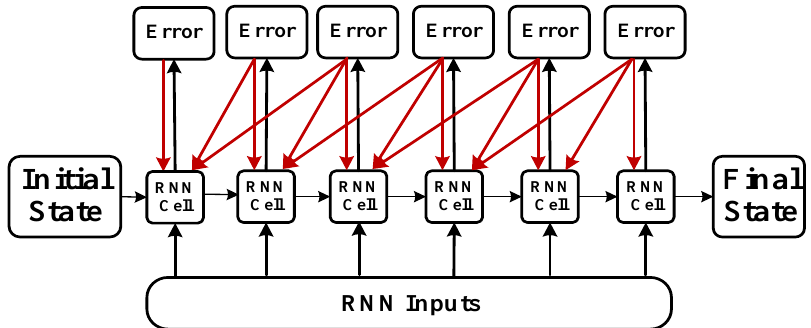
Figure 2. Cell unit interconnection diagram.